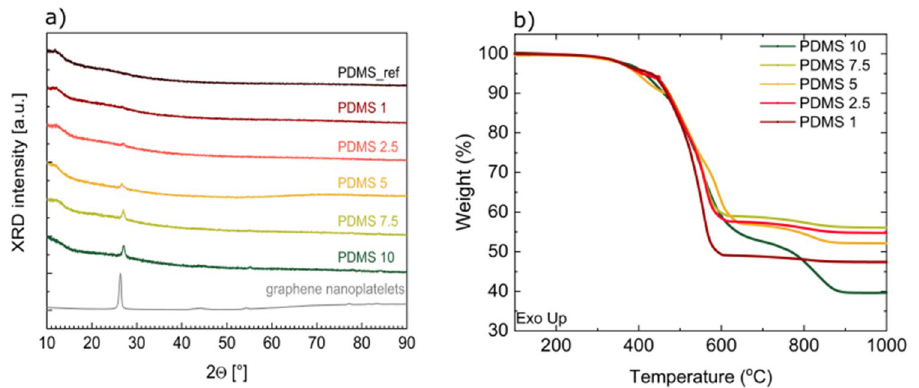
Figure 5. ( a ) Diffractograms of pure PDMS (grey curve) and nanocomposites with different graphene addition (green to blue). The pattern of the graphene nanoplatelets (black curve) was given for comparison. ( b ) Typical TGA thermogram of a graphene/PDMS nanocomposite. Numbers (1–10) stands for respective wt% graphene